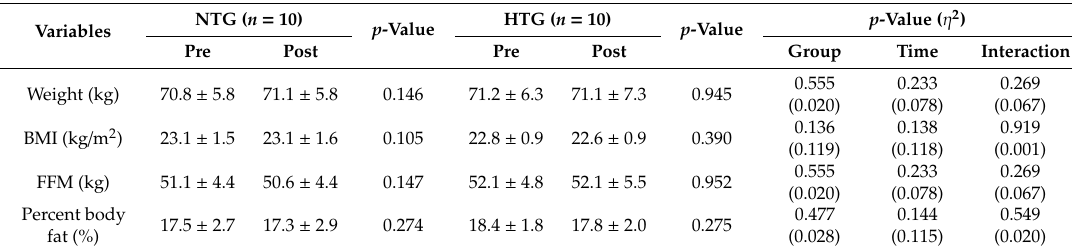
Table 2. Changes in the body composition of the competitive runners before and after the tests.